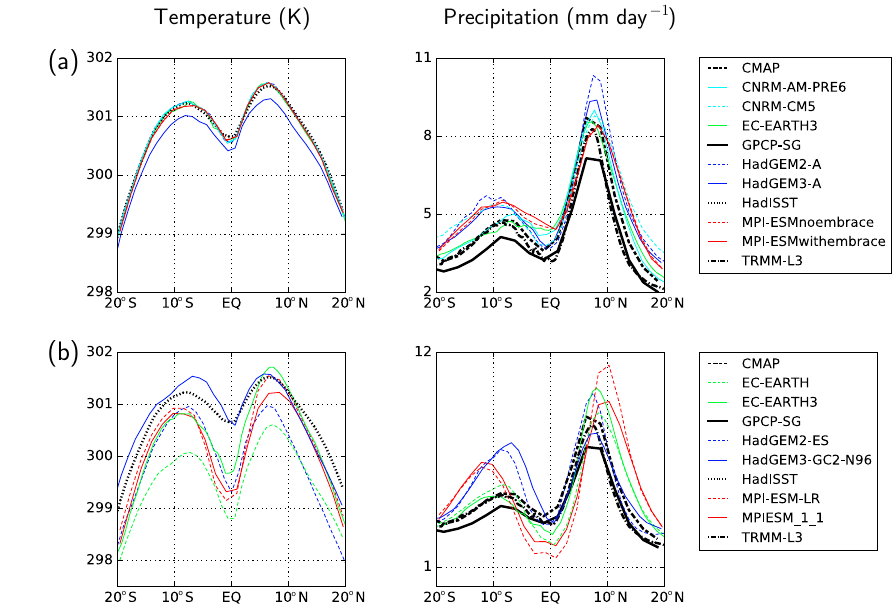
Figure 14. Latitude cross section of DJF SST in K (left column panels) and precipitation in mm per day (right column panels from (a) the AMIP simulations and (b) the coupled (historical) simulations in comparison with observations (HadISST for SST and CMAP, GPCP, and TRMM for precipitation). Values are zonal means averaged over all ocean grid cells in the longitude band 120 ◦ E to 100 ◦ W and averaged over the years 1982–2002 (MPI AMIP models